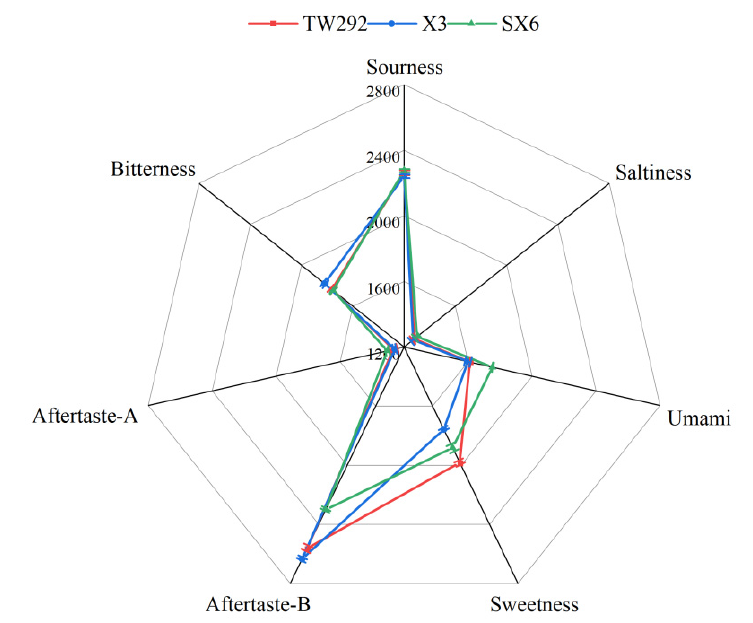
Figure 3. Radar map of the response of electronic tongues of three vegetable soybeans.